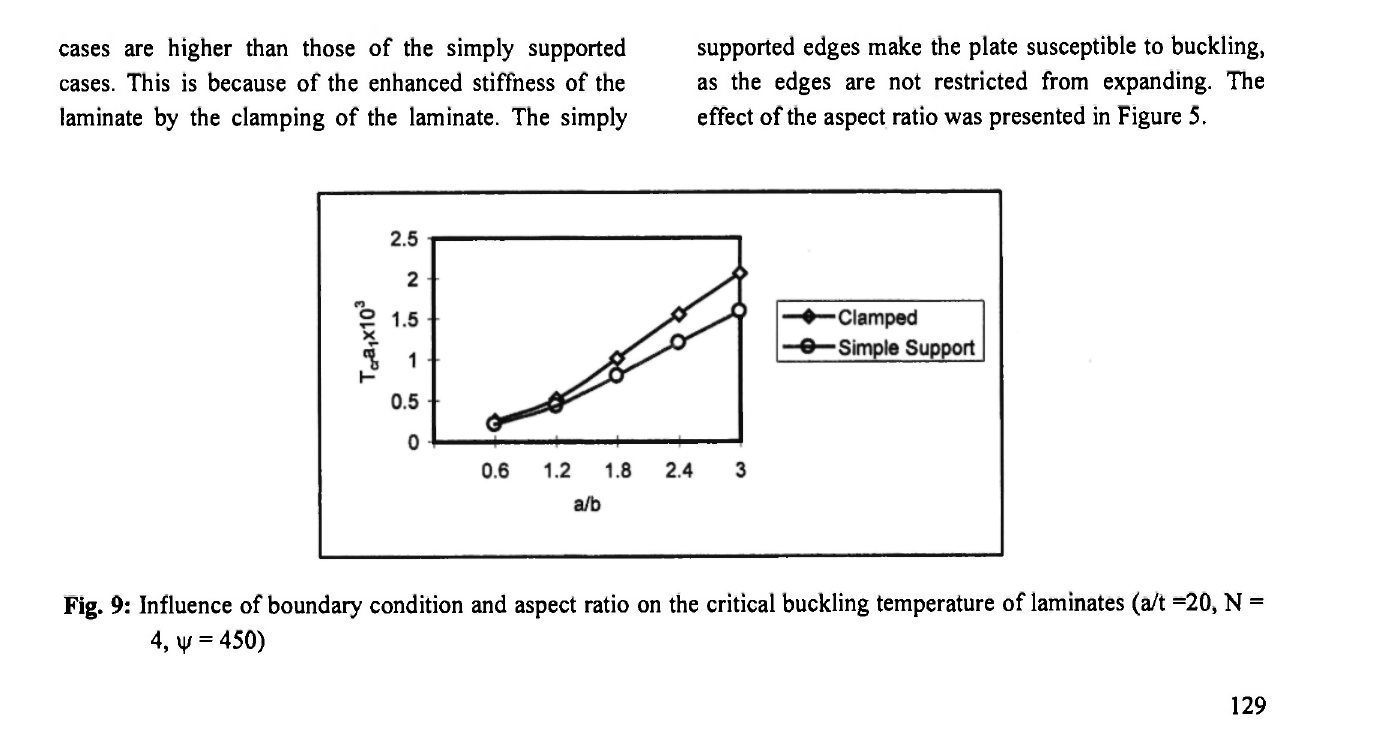
Fig. 8: Effect of thermal expansion ratio on the critical buckling temperature of laminates (a / b = 1, a /1 = 20, ψ = 450)